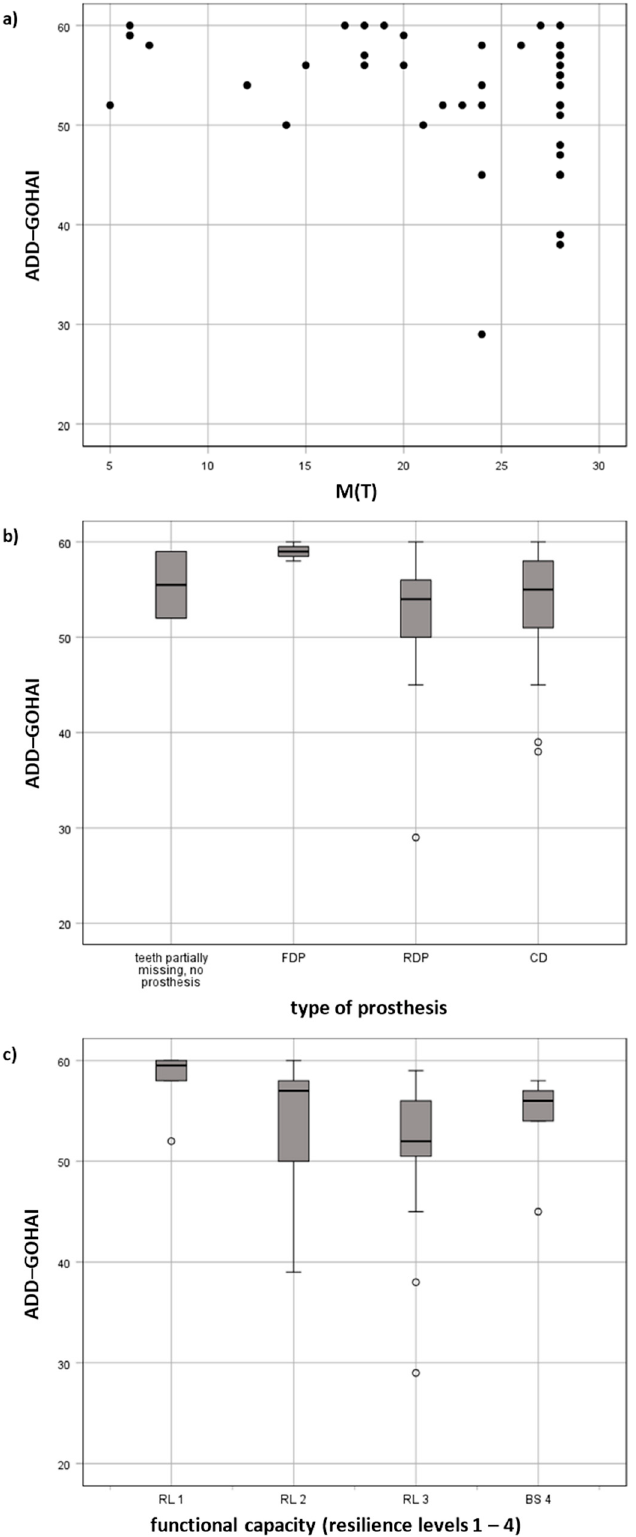
Figure 2. Influencing factors of OHRQoL in centenarians: ( a ) association of missing teeth M(T) with the ADD-GOHAI (scatter plot), ( b ) association of the type of dental prosthesis and ( c ) dental functional capacity with the ADD-GOHAI (box plots).